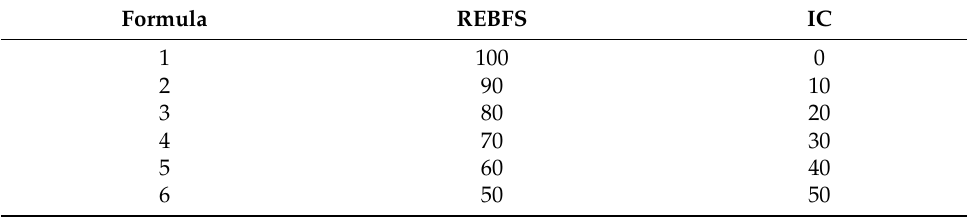
Table 2. Ceramic formulas and proportions of raw materials (wt.